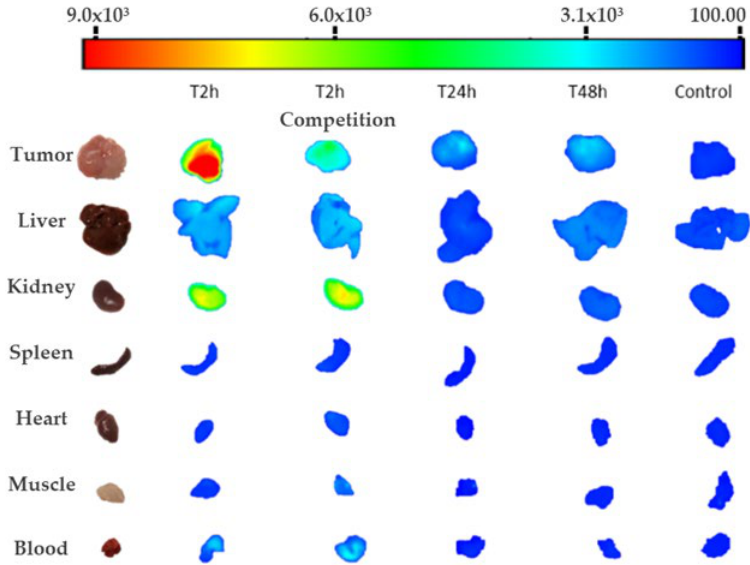
Figure 2. Representative image of quantified fluorescence expressed in principal organs for every ex vivo assay performed.